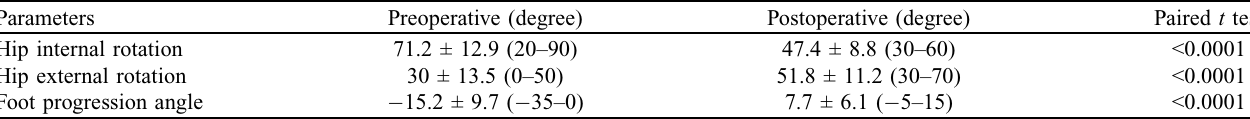
Table 2. Physical examination data pre- and postderotation osteotomy.